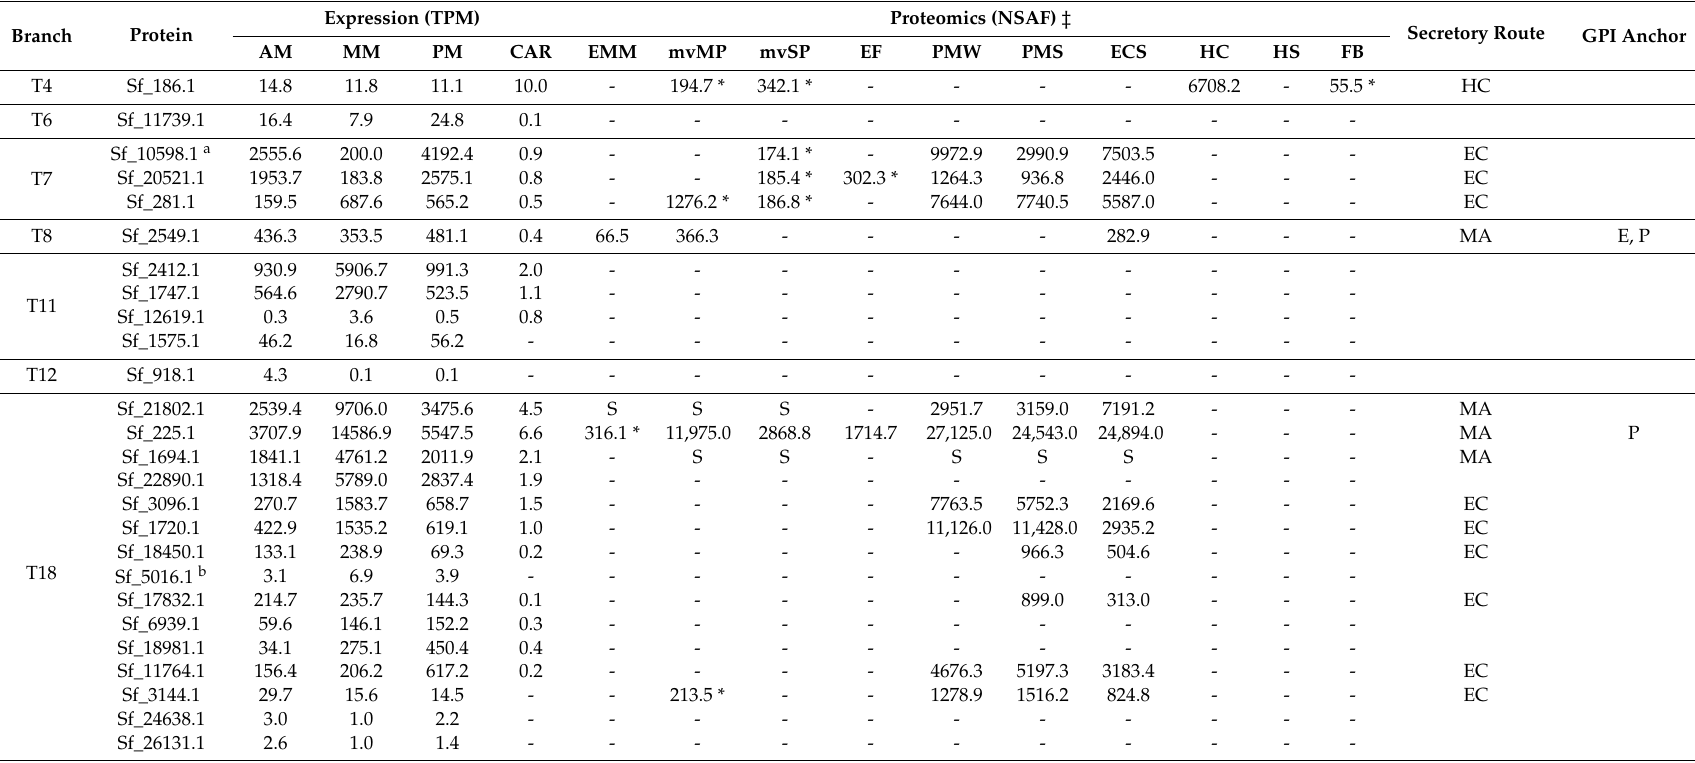
Table 1. Spodoptera frugiperda trypsin gene expression and proteomic analysis